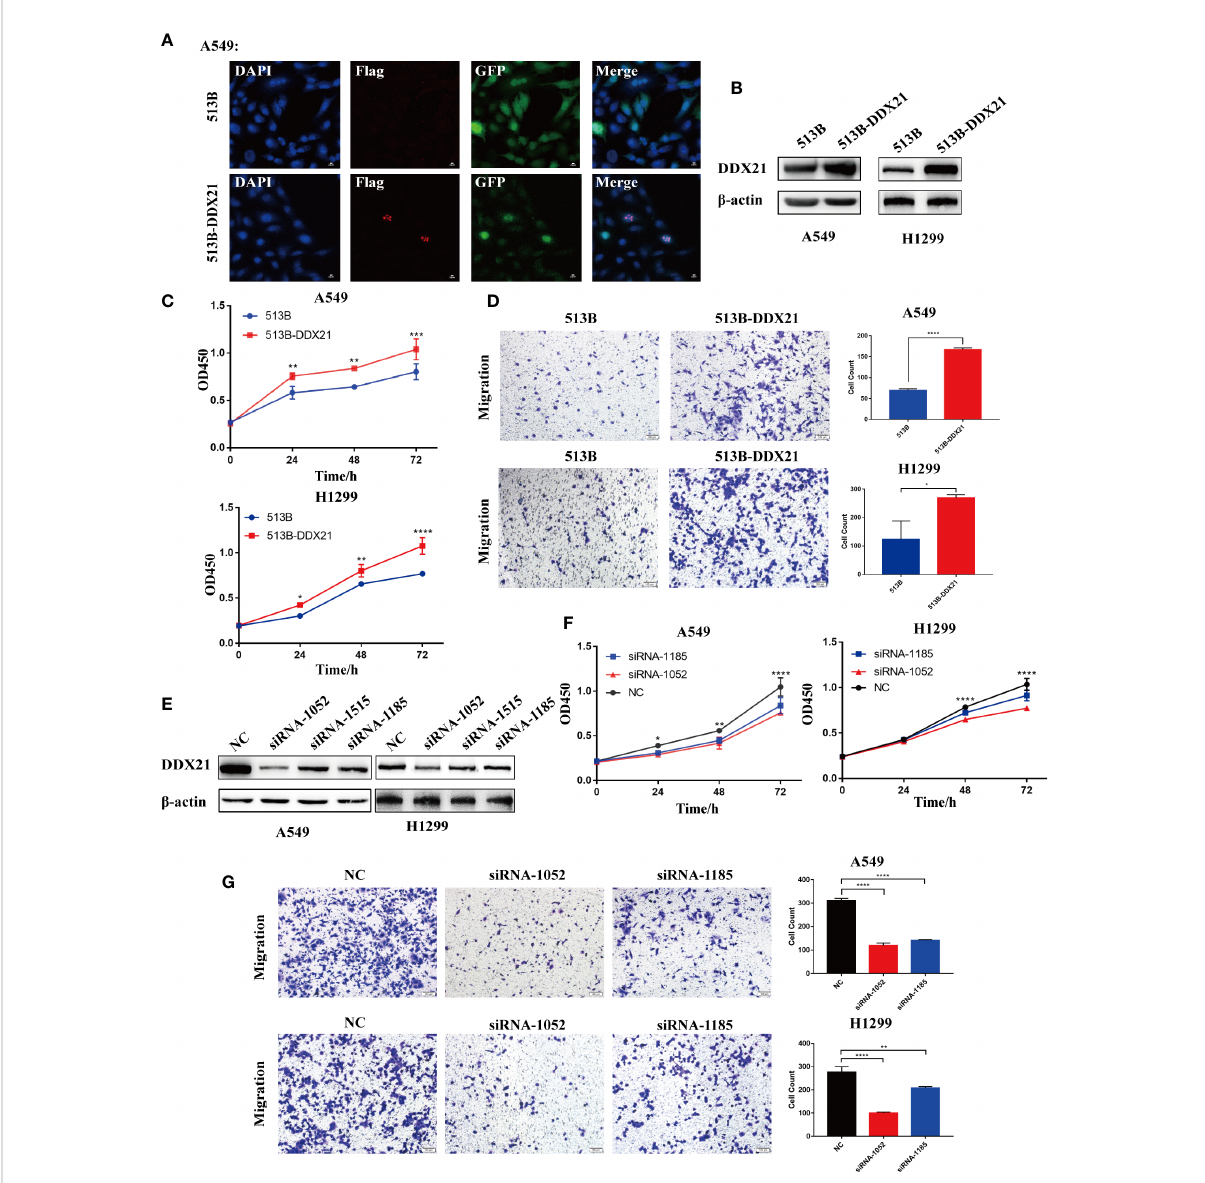
FIGURE 9 DDX10 promoted lung adenocarcinoma cancer cell growth and metastasis in vitro . (A) The localization of Flag-tagged DDX21 assayed by indirect immuno fl uorescence in DDX21 overexpression A549 cells. (B – D) A549 and H1299 cells were infected with lentivirus. Western blot was performed to detect the expression of DDX21; cell growth was detected by CCK-8 assays after 0, 24, 48, and 72 h (n = 3), and cell migration was evaluated by Transwell migration assay. (E – G) A549 and H1299 cells were transfected with siRNA target to DDX21, and cell proliferation and migration were evaluated by CCK-8 and Transwell migration assay, respectively. (*p < 0.05; **p < 0.01; ***p < 0.001, ****p <